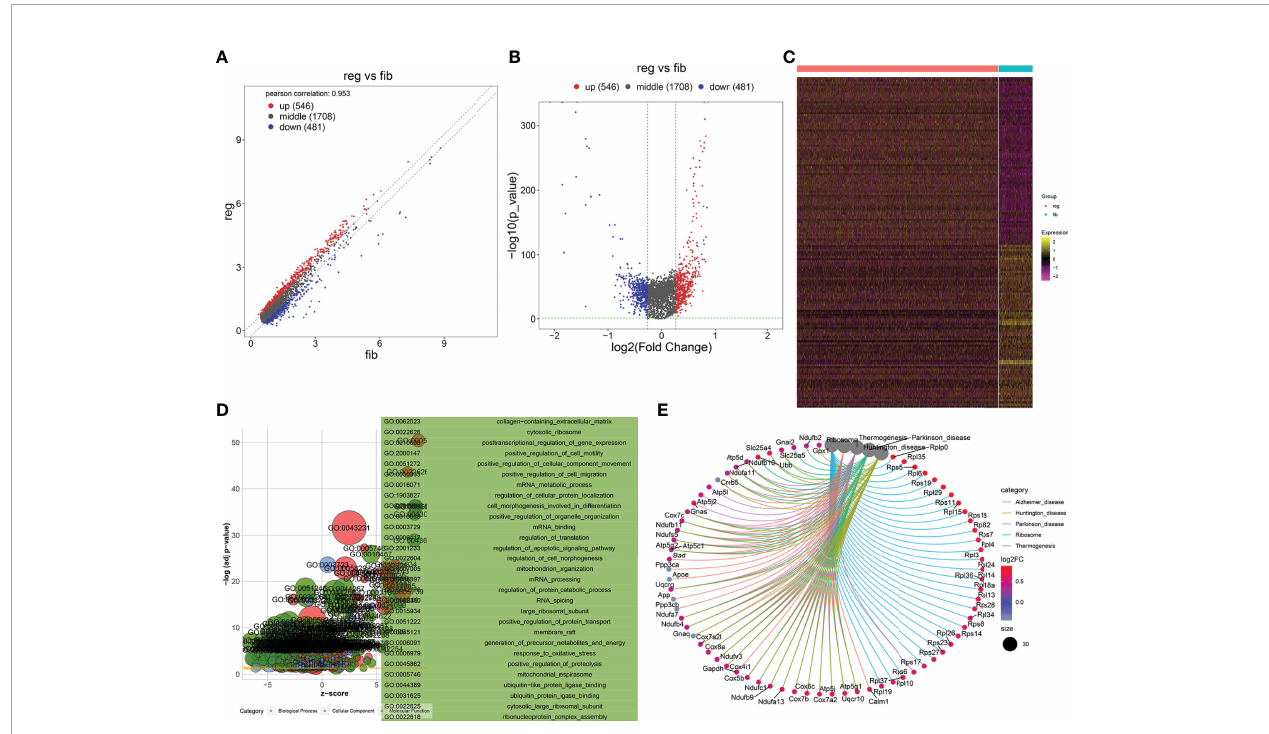
FIGURE 4 | Identi fi cation of speci fi c genes between fi brotic and regenerative myo fi broblasts and their biological functions. (A, B) Scatter plots and volcano diagram for the up- and downregulated speci fi c genes in regenerative (reg) compared to fi brotic ( fi b) myo fi broblasts. Red dots meant upregulated genes while blue dots meant downregulated genes. (C) Heatmap visualizing the expression patterns of the speci fi c genes in fi brotic and regenerative myo fi broblasts. Yellow represented upregulation and purple represented downregulation. (D) GO enrichment results of speci fi c genes that were abnormally expressed between fi brotic and regenerative myo fi broblasts. (E) KEGG pathways involved in speci fi c genes that were abnormally expressed between fi brotic and regenerative myo fi